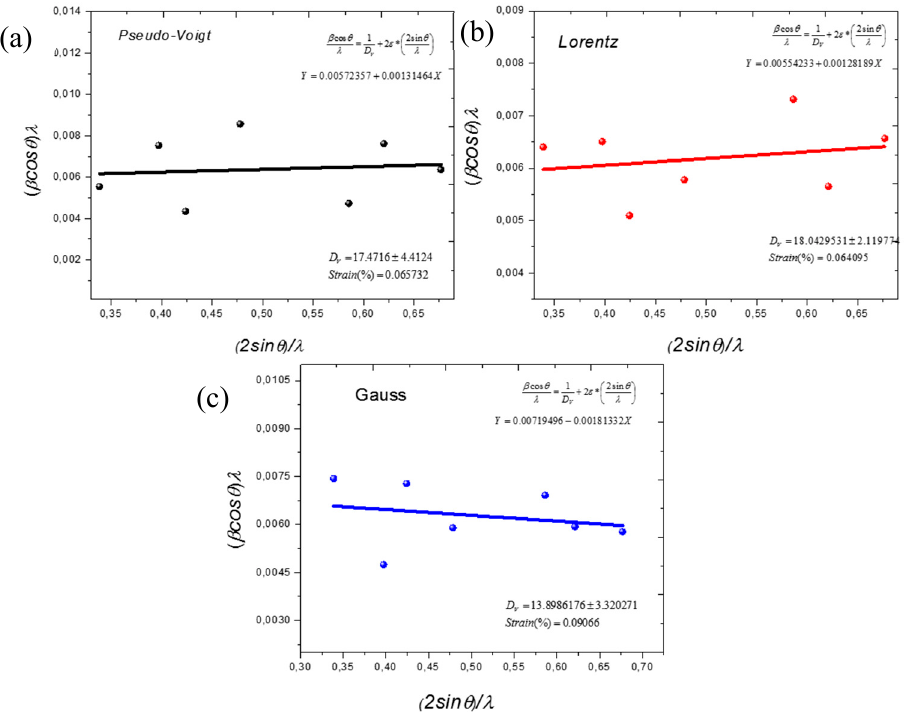
Figure 4. Williamson-Hall plot of the Fe 3 O 4 NPs synthesized by Cnicus benedictus calculated by the ( a ) Pseudo-Voigt, ( b ) Lorentz and ( c ) Gauss functions.